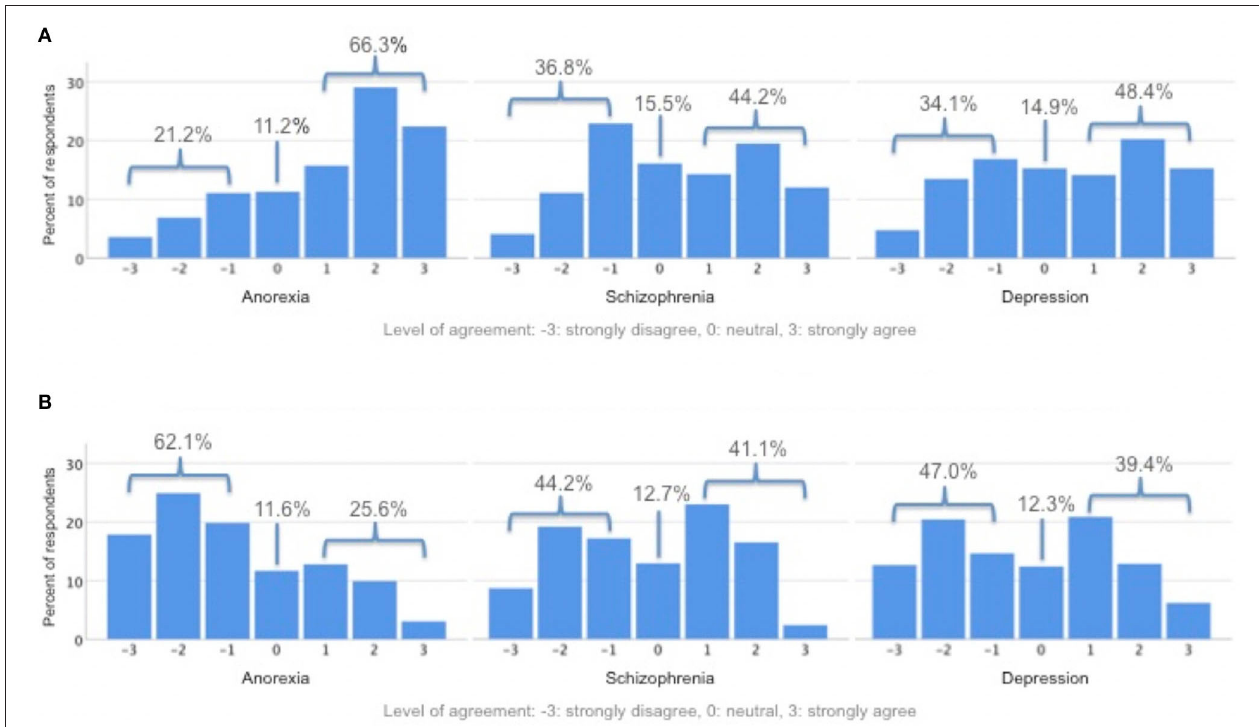
FIGURE 1 | (A) In this case, I would not proceed against patient’s wishes. (B) In this case, I would accept a temporary decrease in quality of life because of coercive